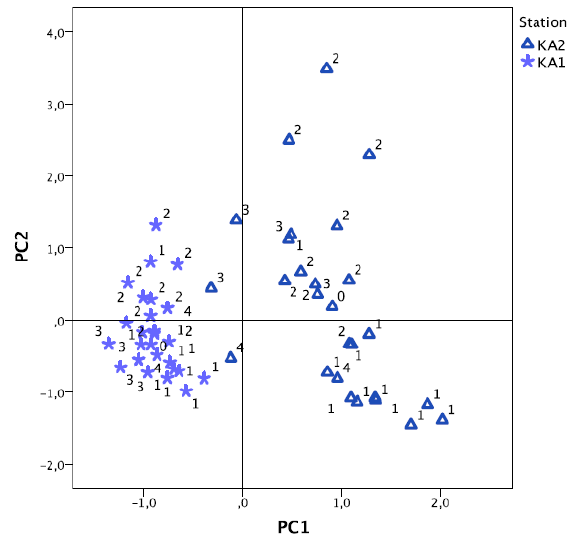
Figure 5. Scatter plot of the scores for sites KA1 and KA2 corresponding to 26 sampling campaigns labeled by season: (1) summer, (2) autumn, (3) winter and (4) spring.